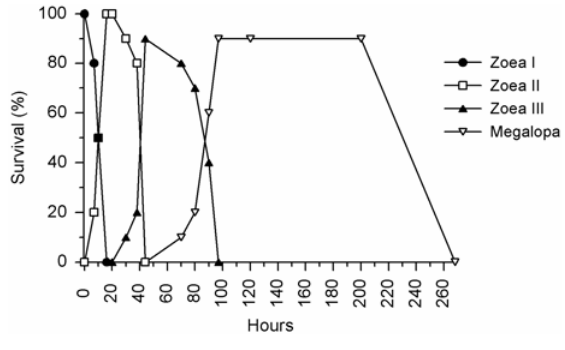
Fig. 8 – Survival (%) and intermoulting period (hours after hatching) of Lepidophthalmussiriboia larvaerearedinthelaboratoryandsubmit- ted to an initial starvation period. In this treatment, they were starved during 2 days.